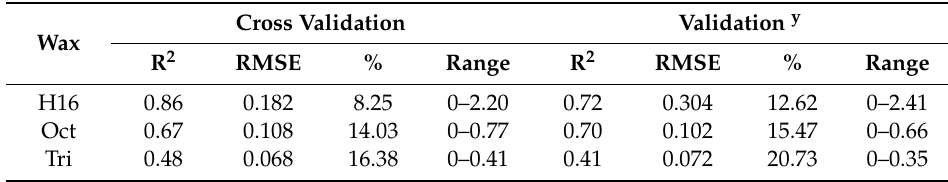
Table 4. Spectroscopy validation parameters, R2 values, root-mean-square error (RMSE), range of the interval, and percentage of error within the range for cross calibration and validation models for Hentriacontanone-16 (H16), Octacosanol-1(Oct), and Triacontanol-1 (Tri) on the foliage of seven onion accessions (Table